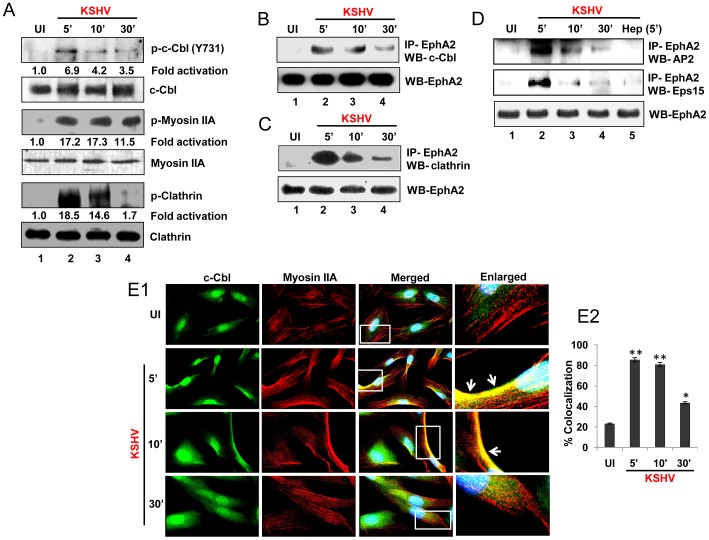
Endocytic effectors critical for clathrin mediated entry are activated and associated with EphA2 early during KSHV infection.(A) Serum-starved HFF cells were either mock infected (UI) or infected with KSHV (30 DNA copies/cell) for the indicated time periods and subjected to Western blot analysis for phospho-c-Cbl (p-c-Cbl) (Y731) and phospho-myosin IIA (S-19). For clathrin activation, cell lysates were subjected to immunoprecipitation with anti-clathrin heavy chain antibody followed by Western blot analysis with anti-phosphotyrosine antibody (4G10). Blots were stripped and reprobed for the respective total c-Cbl, myosin and clathrin. (B,C and D) Serum-starved HFF cells were left uninfected (UI) or infected with KSHV for the indicated periods of time and immunoprecipitated with anti-EphA2 antibodies and analyzed for c-Cbl, clathrin or clathrin adaptors AP2 and Epsin15 by Western blots which were stripped and reprobed for EphA2. For heparin treatment of KSHV, virus was pre-incubated with heparin (100 µg/ml) for 1 h at 37°C and used for infecting cells for 5 min. (E) Serum-starved HFF cells either uninfected or infected with KSHV for the indicated time points were subjected to immunofluorescence assay using mouse anti-c-Cbl and rabbit anti-myosin IIA antibodies for 2 h at room temperature followed by staining with anti-mouse Alexa fluor 488 and anti-rabbit Alexa fluor 594, respectively. Representative 2D convoluted images are shown (E1). The enlarged pictures represent boxed regions within the merged panels and the white arrows represent colocalization of the indicated molecules. Quantitation of cells showing c-Cbl and myosin IIA colocalization (E2). At least three different microscopic fields having at least 10 cells each were chosen to analyze the colocalization efficiency. Error bars represent mean ± SD, * represents p<0.05 and ** represents p<0.01.